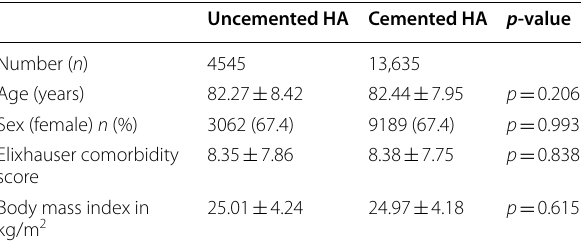
Table 1 Anthropometry and risk factors before and after matching of the patient cohort with cemented and uncemented hemiarthroplasty after femoral neck fracture